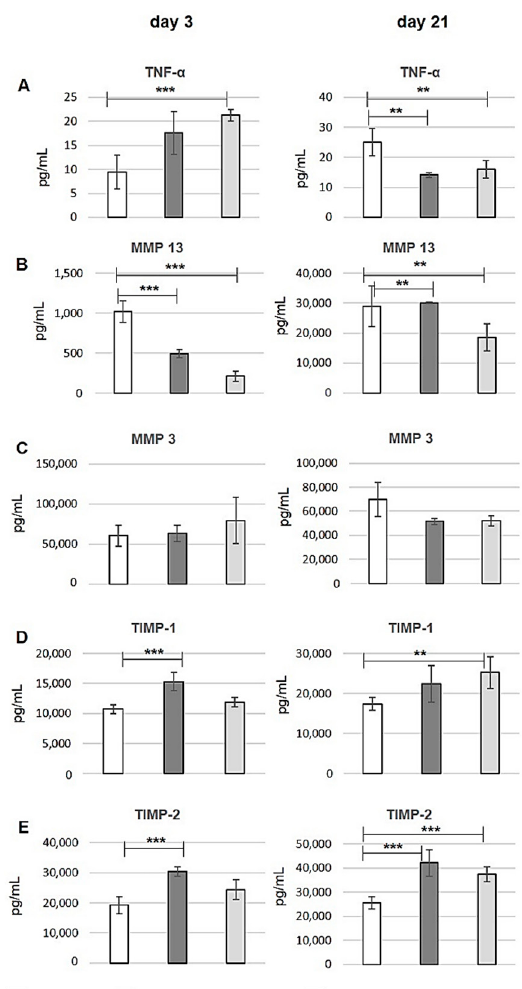
Figure 6. Quantification of proteins in culture supernatants. Analysis of supernatants at days three and 21 of OA osteochondral explant alone (white bars), explant seeded with hBMSCs with/without KGN (light grey/dark grey bars). Total amount of proteins in pg/mL: ( A ) TNF- α ; ( B ) MMP 13; ( C ) MMP 3; ( D ) TIMP-1; and ( E ) TIMP-2 were quantified by multiplex ELISA assay ( n = 3). ** p < 0.01, *** p < 0.001 vs. the control group (OA osteochondral explant without cell loading).